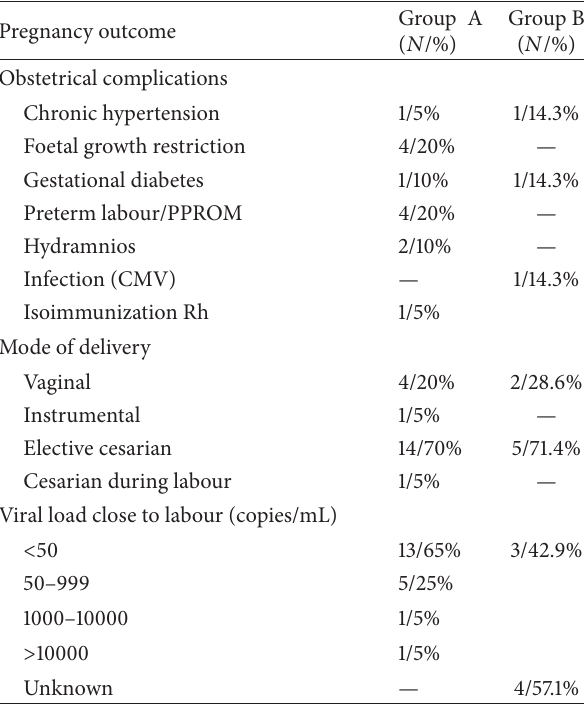
Table 2: Characteristics of amniocentesis. Table 3: Pregnancy